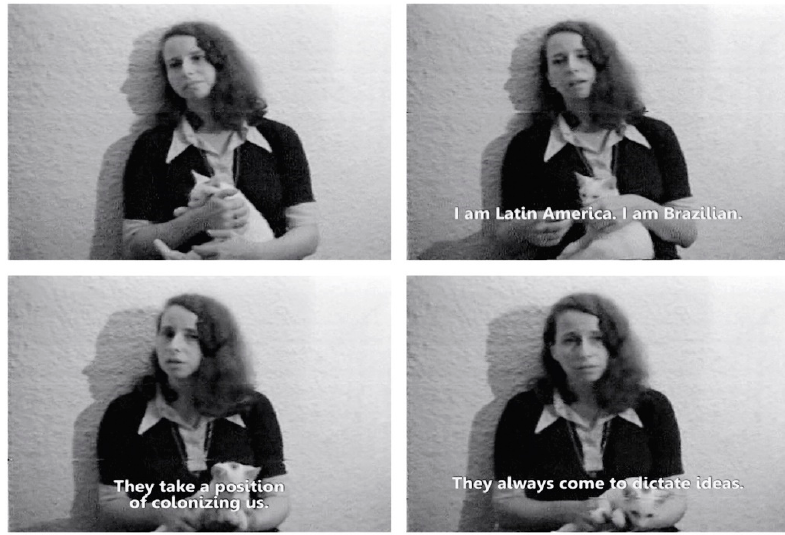
Figure 1. Anna Bella Geiger, Declaração em retrato No. 1 ( Statement in Portrait No. 1 ), 1974. Single channel video, black and white, sound. Duration: 16 min. 18 sec. Videographer: Tom Job Azulay. Edition of 5 + 2 AP. (Film still) Courtesy of the artist and Henrique Faria, New York.